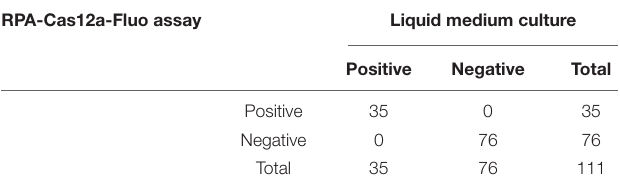
TABLE 1 | The comparison of the RPA-Cas12a-Fluo assay and liquid medium culture for M. hominis detection in clinical samples. RPA-Cas12a-Fluo